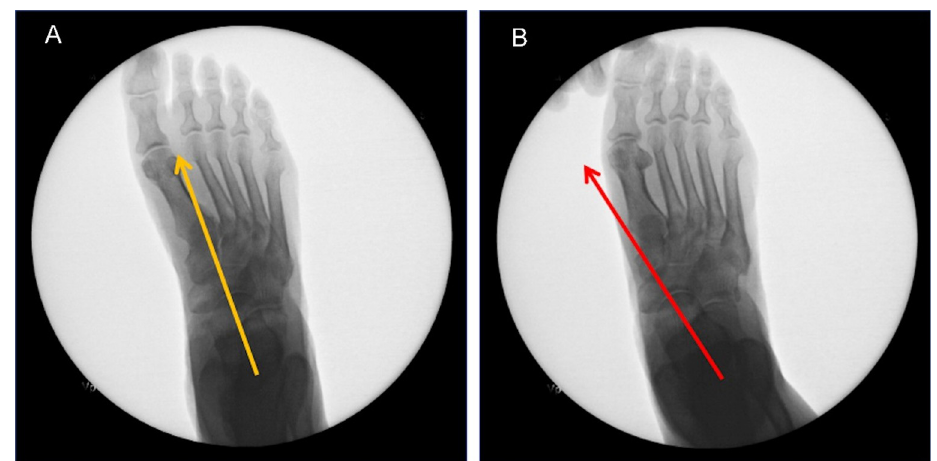
Fig 1. Simulated weightbearing dorsoplantar fluoroscopic